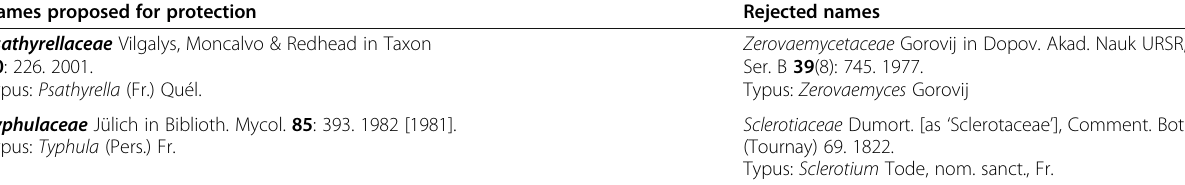
Table 3 Family names proposed for protection with the names proposed for rejection. See text for the rationale about the proposed protected names. This list provides the names to be protected or rejected, author, their place and date of publication, and type. The names proposed for protection will be evaluated and recommended for approval by the Nomenclature Committee for